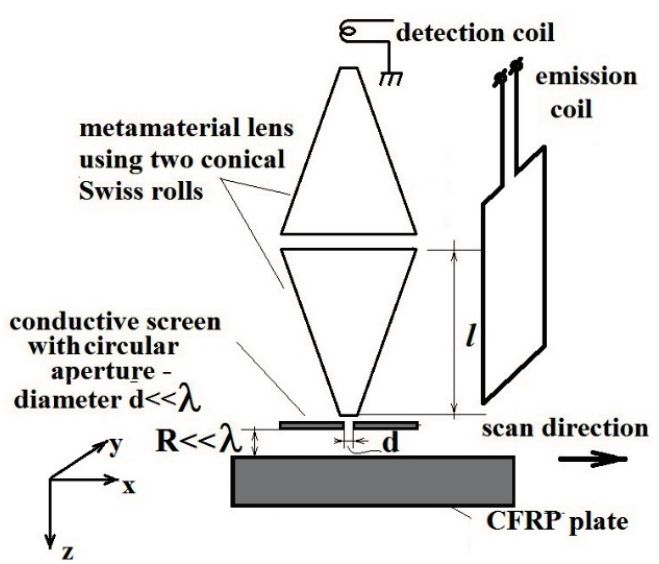
Figure 1. Schematic representation of the Sensor with MM